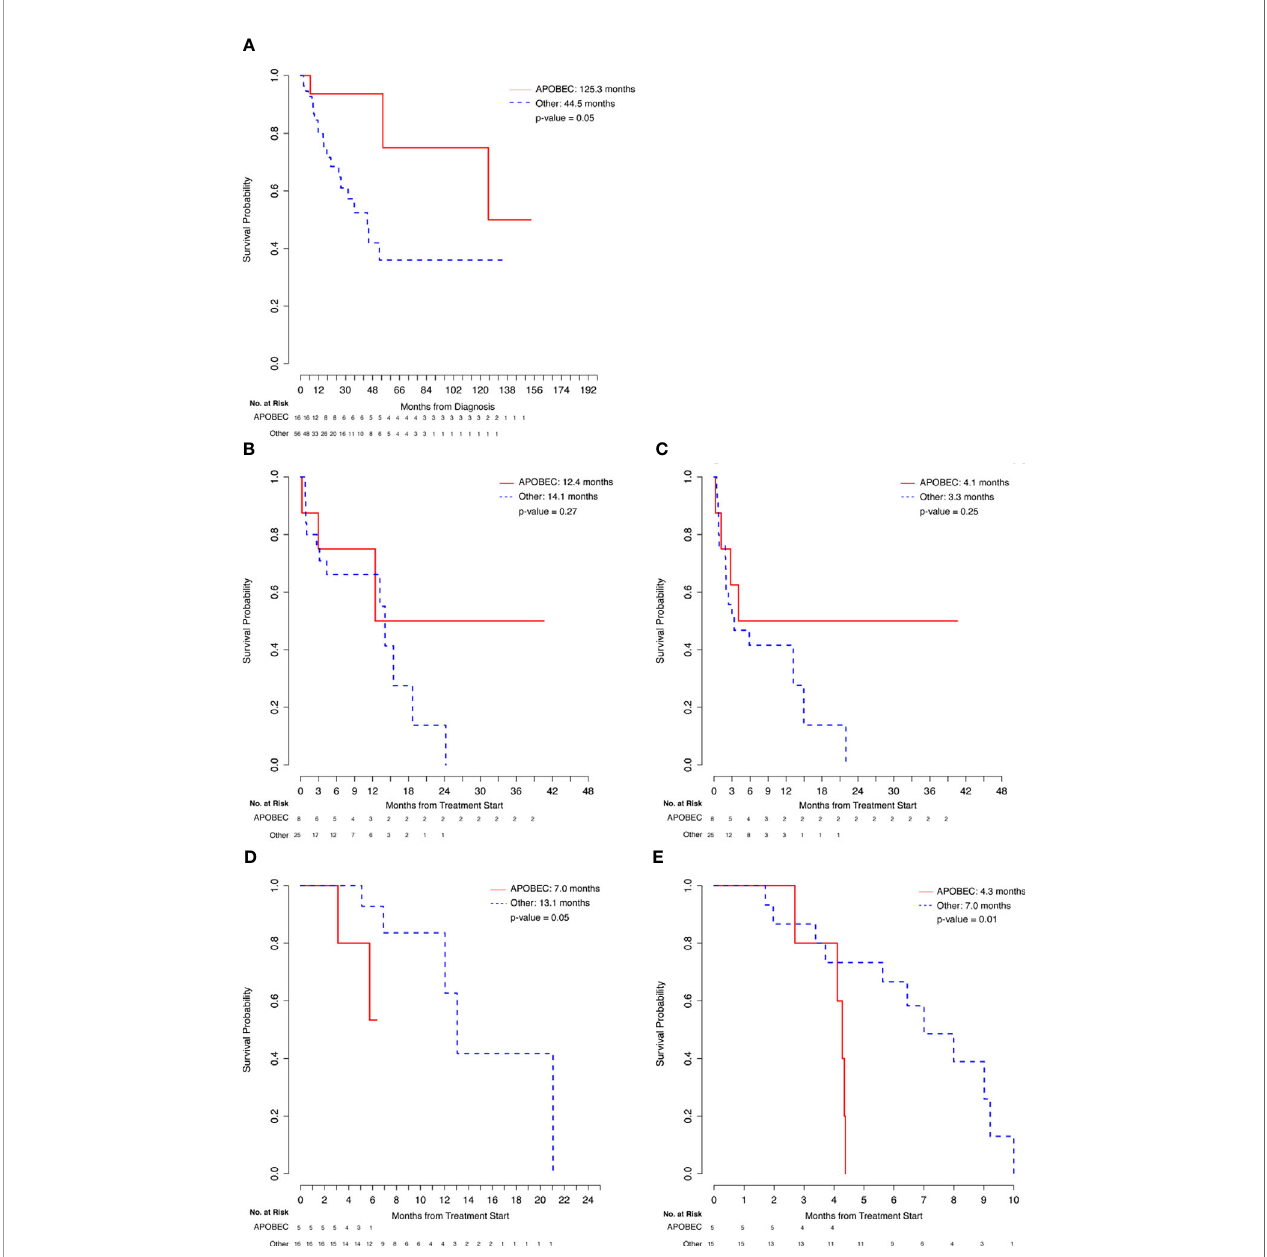
FIGURE 3 | Comparison of APOBEC and Other patients. (A) Overall Survival from Diagnosis. (B) Overall Survival from Immunotherapy Start. (C) Progression-Free Survival from Immunotherapy Start. (D) Overall Survival from Chemotherapy Start. (E) Progression-Free Survival from Chemotherapy